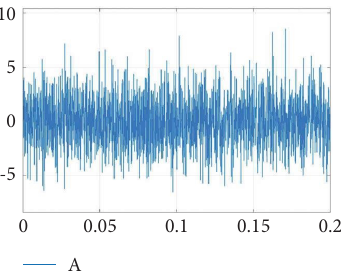
Figure 3: Noise characteristic diagram of a cable.